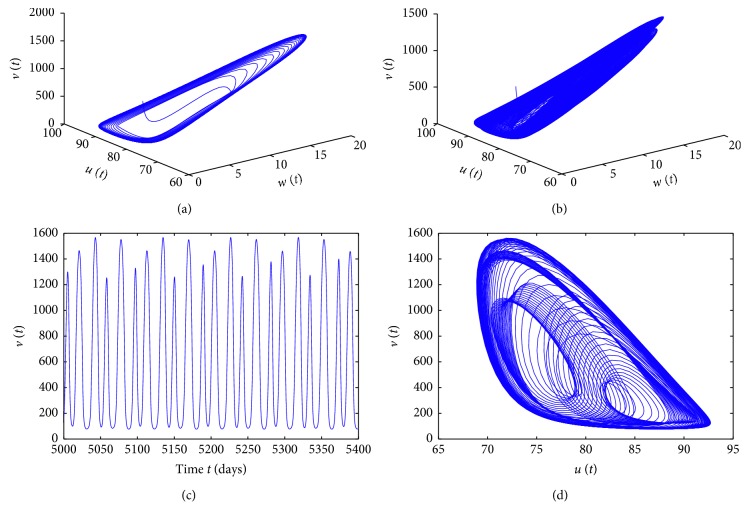
Solutions of the model for τ=10 (a), τ=22 (b), and τ=45 (c, d), corresponding to Figure 5(b).